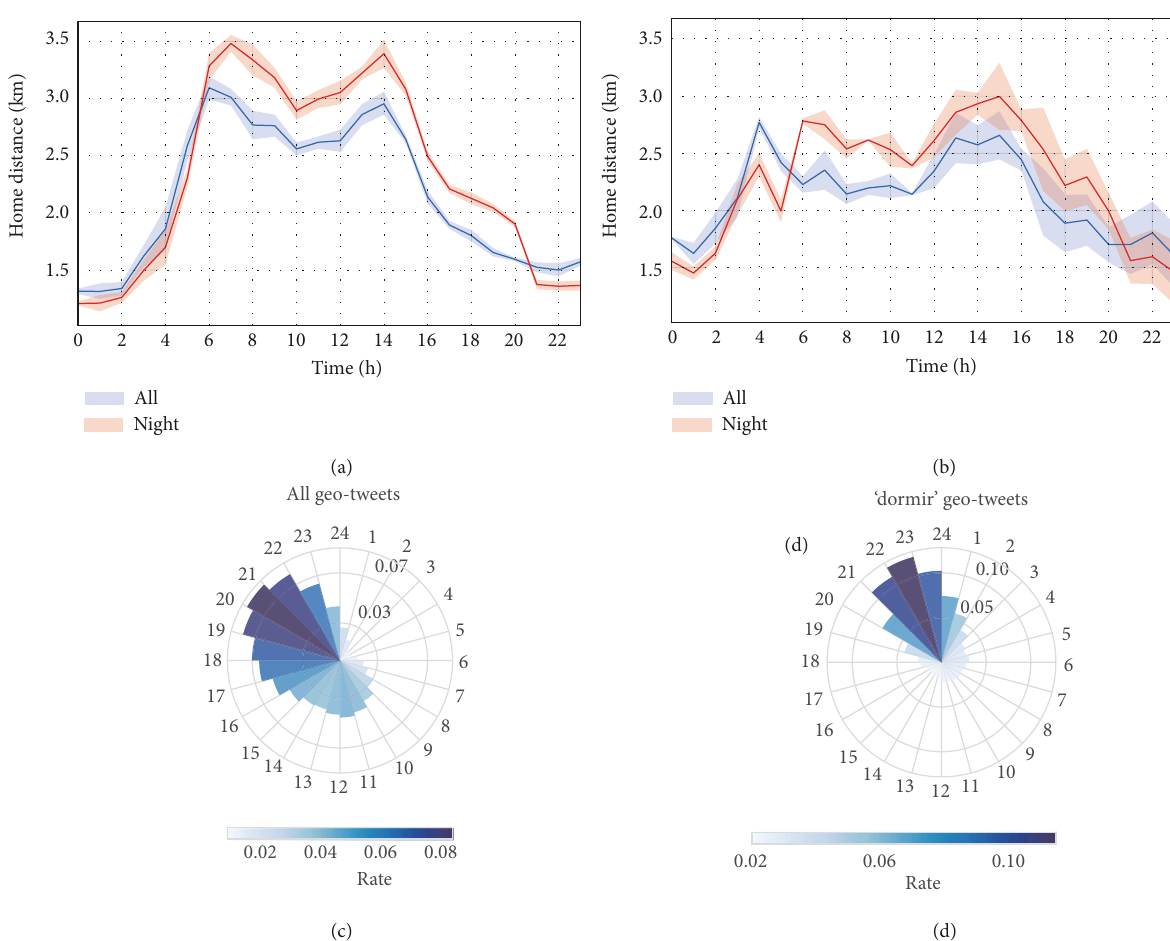
Figure 1: Average distance from home of active users per hour of the day depending on whether the geolocated tweet was posted during a weekday (a) or the weekend (b) and the most frequent location was chosen among all (blue) or only the night ones (red). (c) Hourly rate of all geolocated tweets and (d) geolocated tweets mentioning ‘dormir’ averaged over all